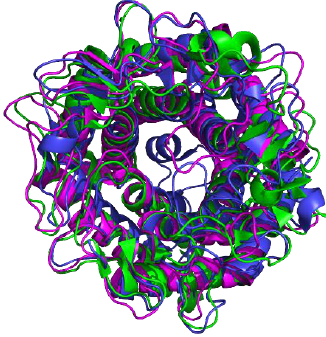
Figure 3. Three-dimensional structure of AGE enzyme family. N -acetyl- D -glucosamine 2-epimerase (PDB code: 1FP3) is highlighted in green; YihS enzyme (PDB code: 2AFA) is highlighted in blue; cellobiose 2-epimerase (PDB code: 3WKG) is highlighted in purple. The central region of this structure is the active site of the AGE family